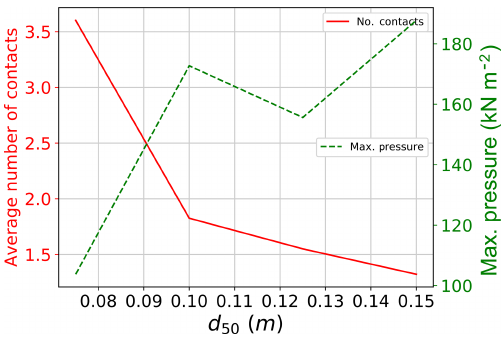
Figure 23. Evolution of pressure on the large plate for different simulations with different d 50 , using φ b = 30 ◦ , α = 30 ◦ .